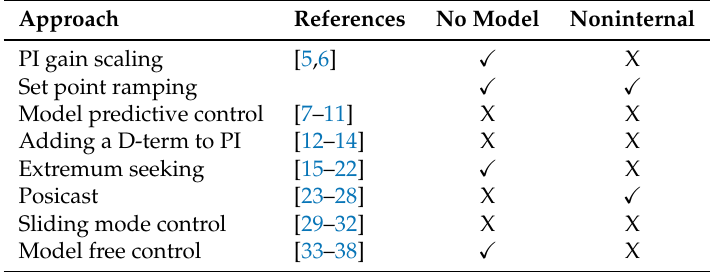
Table 1. Comparison of methods to improve the dynamic response of a system